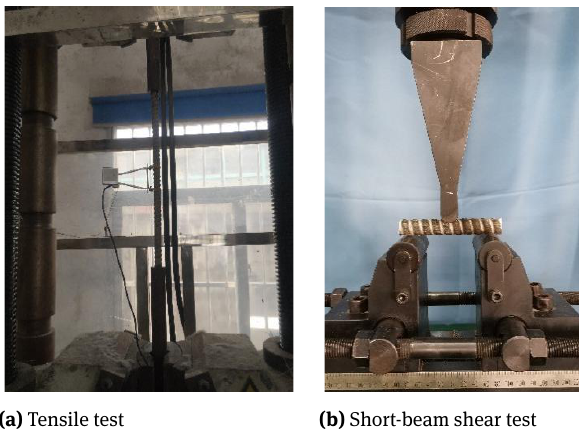
were prepared with span to diameter ratio of 5. Total 60